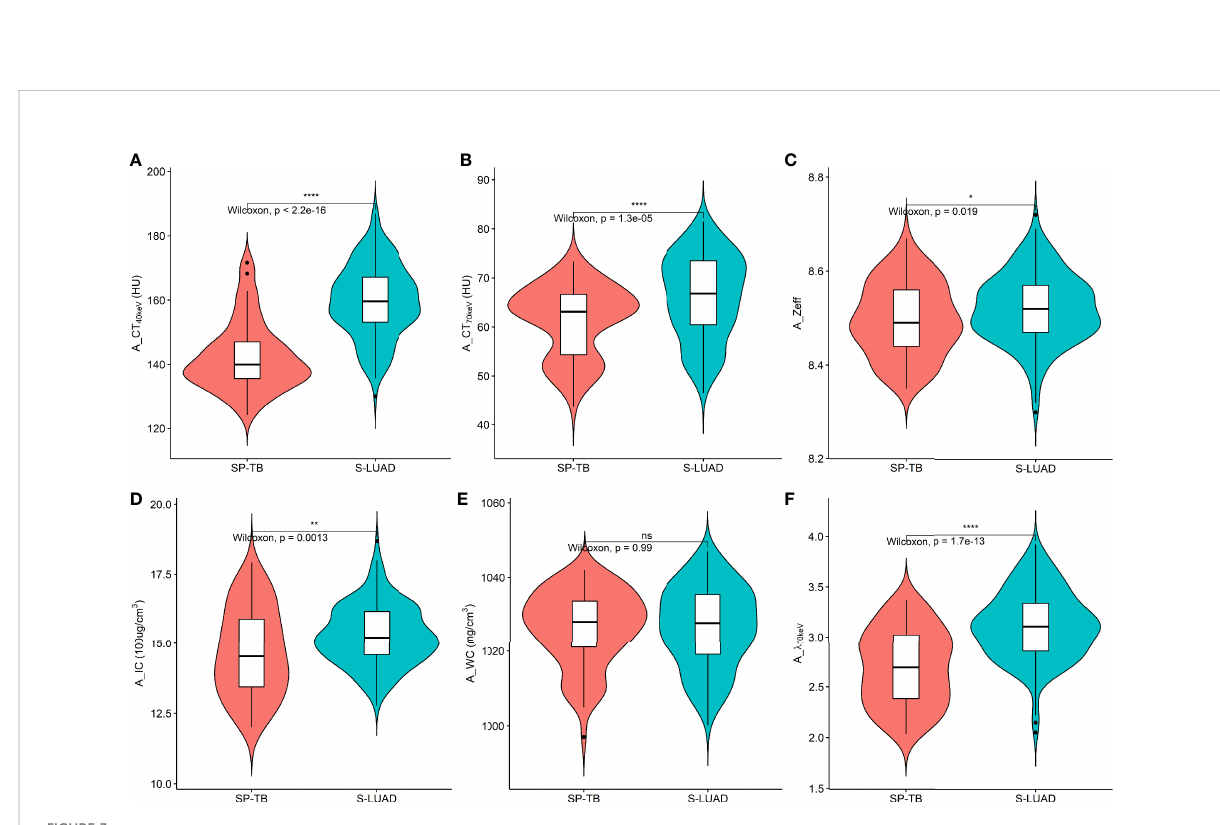
FIGURE 3 Violin plots of dual-energy spectral CT multiparameter for solitary pulmonary tuberculosis (SP-TB) and solitary lung adenocarcinoma (S-LUAD) in the arterial phase. (A) CT 40 keV value; (B) CT 70 keV value; (C) effective atomic number (Zeff); (D) iodine concentration (IC); (E) water concentration (WC); (F) spectral curve slope ( l 70 keV ). * P < 0.05; ** P < 0.01; **** P < 0.0001; Ns, No signi fi cance.